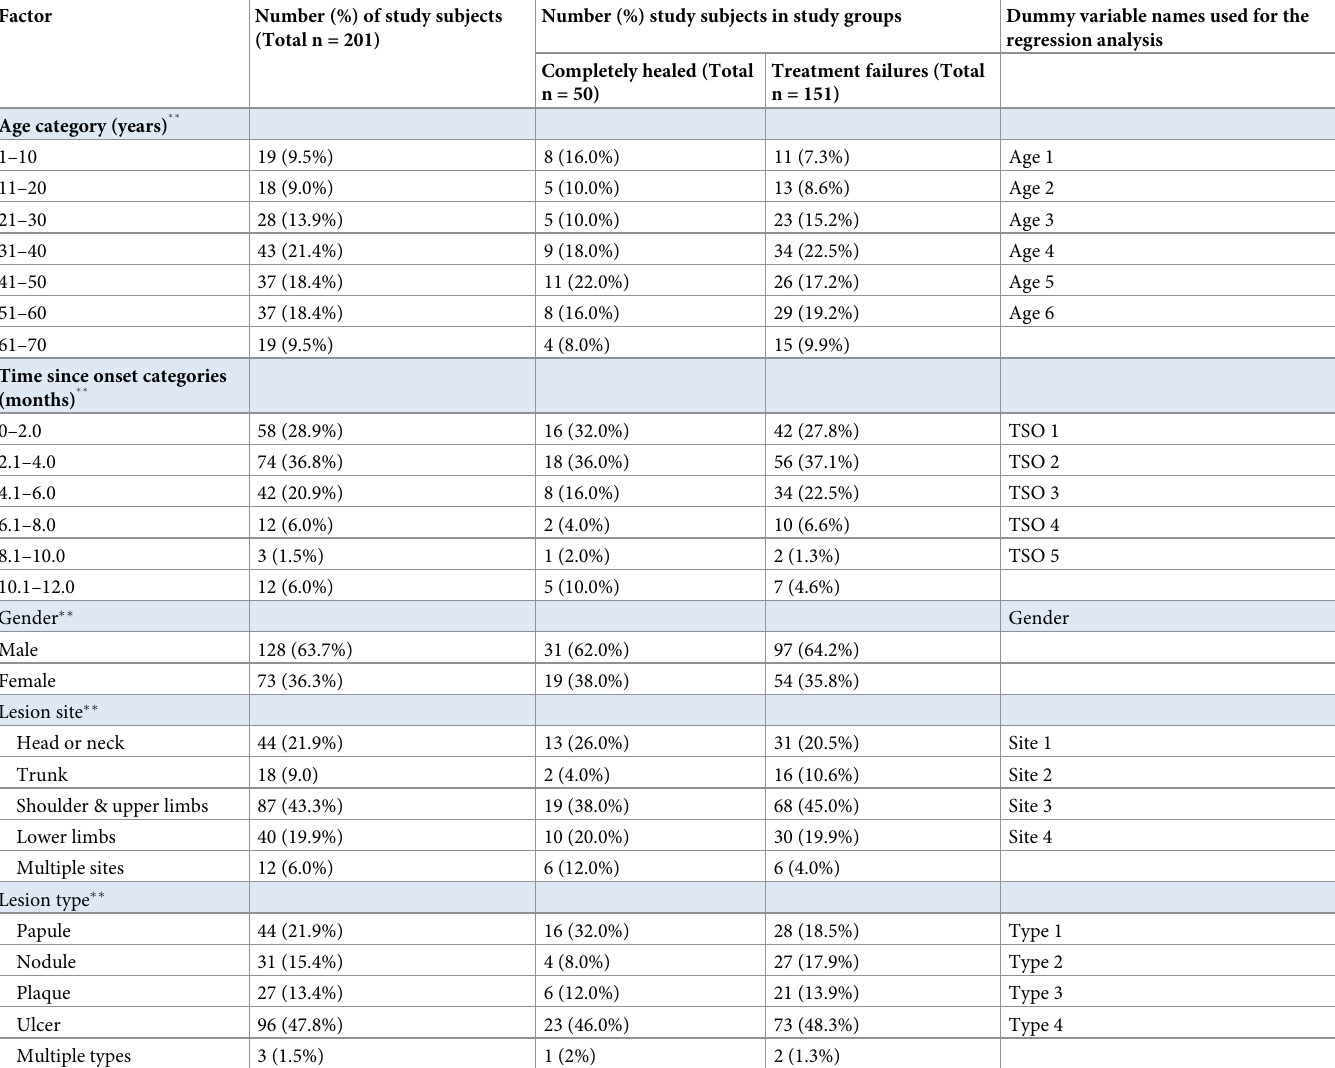
Table 2. Characteristics and frequencies of laboratory-confirmed CL patients who were treated with IL-SSG weekly injections (n =